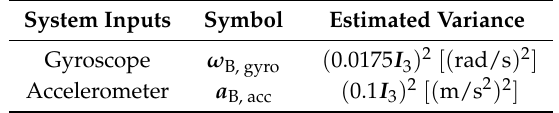
Table 4. Diagonal elements of the estimated process noise covariance matrix Q .